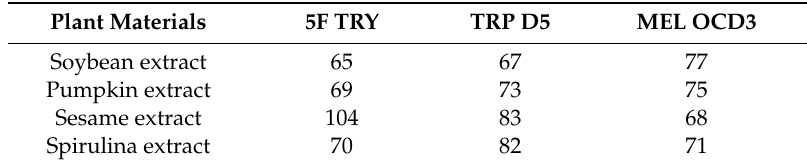
Table 3. Process e ffi ciency (peak area of IS extracted / peak area of IS not-extracted) of internal standards among the di ff erent plant